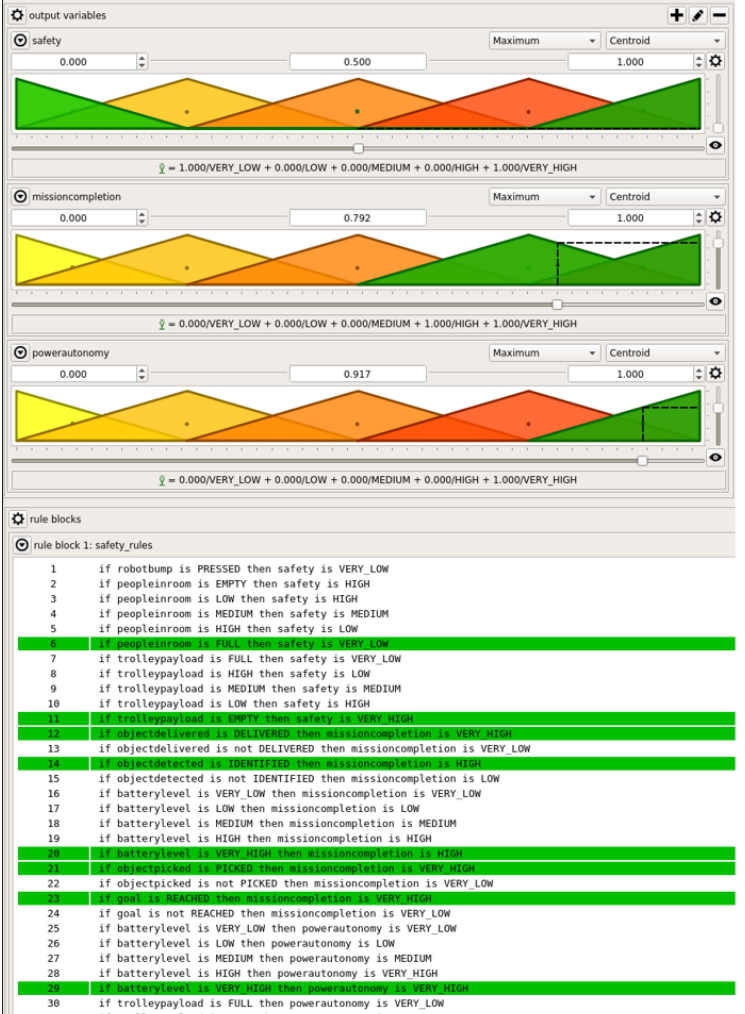
Figure 11. QoS metrics provided by the FuzzyEngine when a person is detected close to the roll container (see